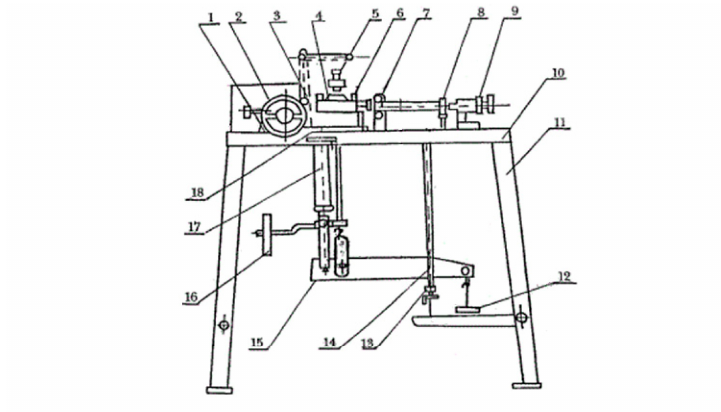
Figure 11. Principle of the ZJ strain-controlled direct shear instrument.